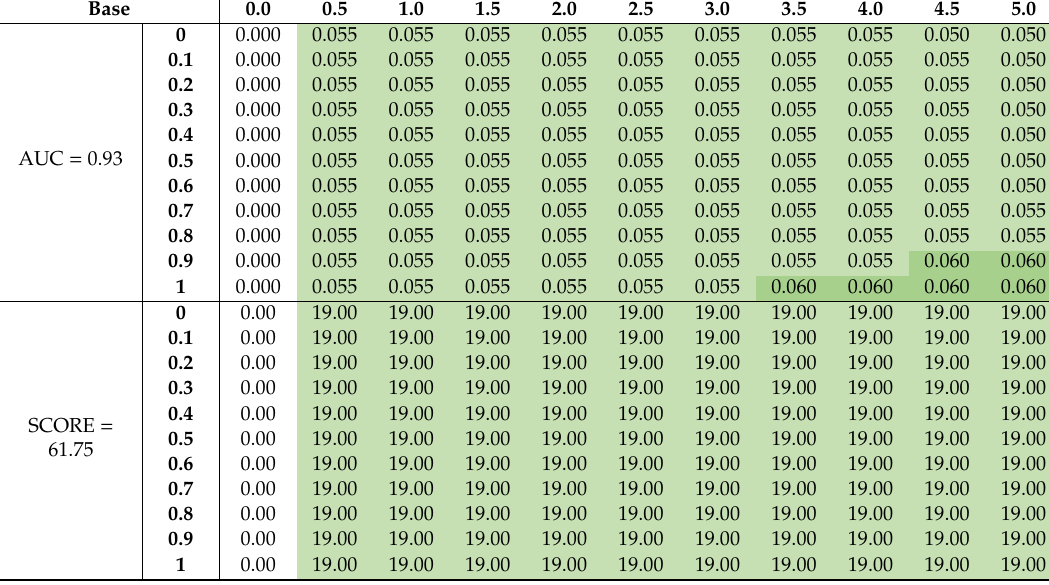
Table 4. Improvement of Area Under the Curve (AUC) and Score for Asystole on validation sample in terms of the α -parameter and p -parameter.